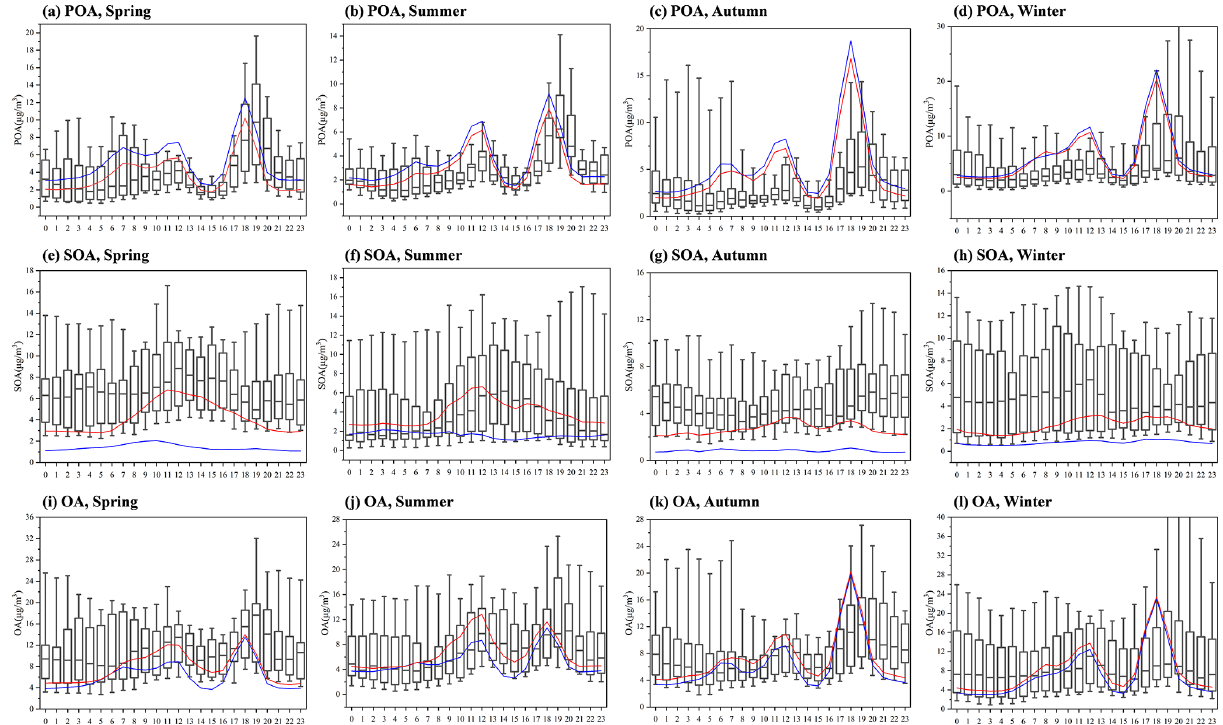
Figure 7. Diurnal patterns of modeled POA, SOA, and OA concentrations in different seasons and their comparisons with the observations at the SAES supersite. The boxplots represent the diurnal patterns of the AMS observations. The blue and red lines, respectively, represent the diurnal patterns of the simulation results in BASE and I/SVOC-E